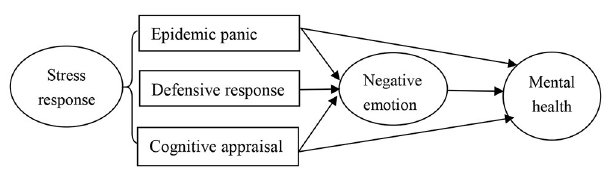
FIGURE 1 | Relationship model between stress response, negative emotion, and mental